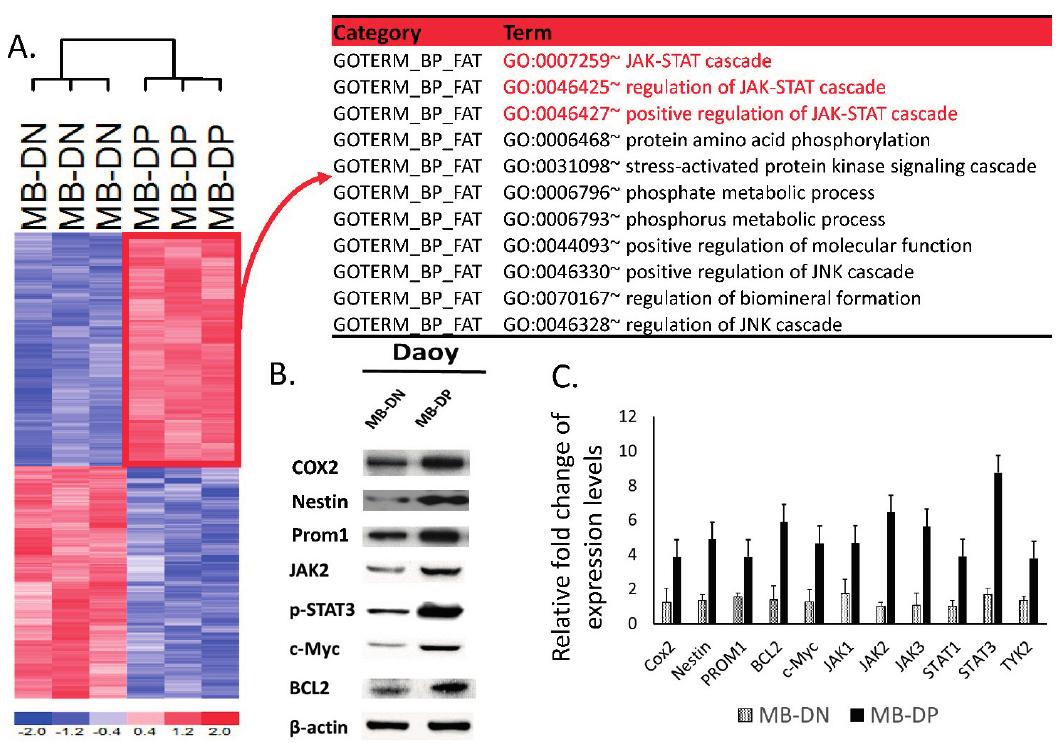
Figure 3. Differential gene expression between MB-DP and MB-DN cells. ( A ) Heatmap of differential gene expression between MB-DP and MB-DN cells. Gene expression microarray analysis showing genes that were differentially expressed in MB-DP and MB-DN